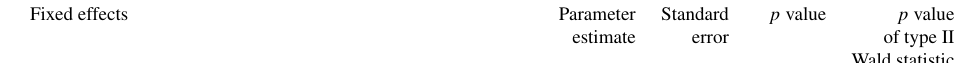
Table 3. Parameter estimates of regression model examining the participants’ perceived effectiveness ratings. Dashes (–) indicate that the level represents the base level of the attribute, and SD stands for standard deviation. The number of observations =